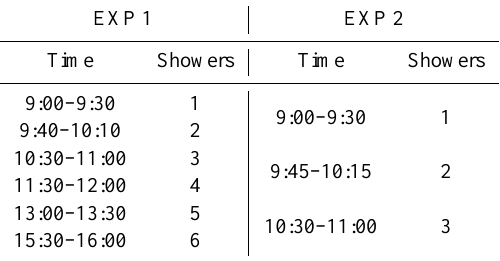
Table 2. Shower schedule per